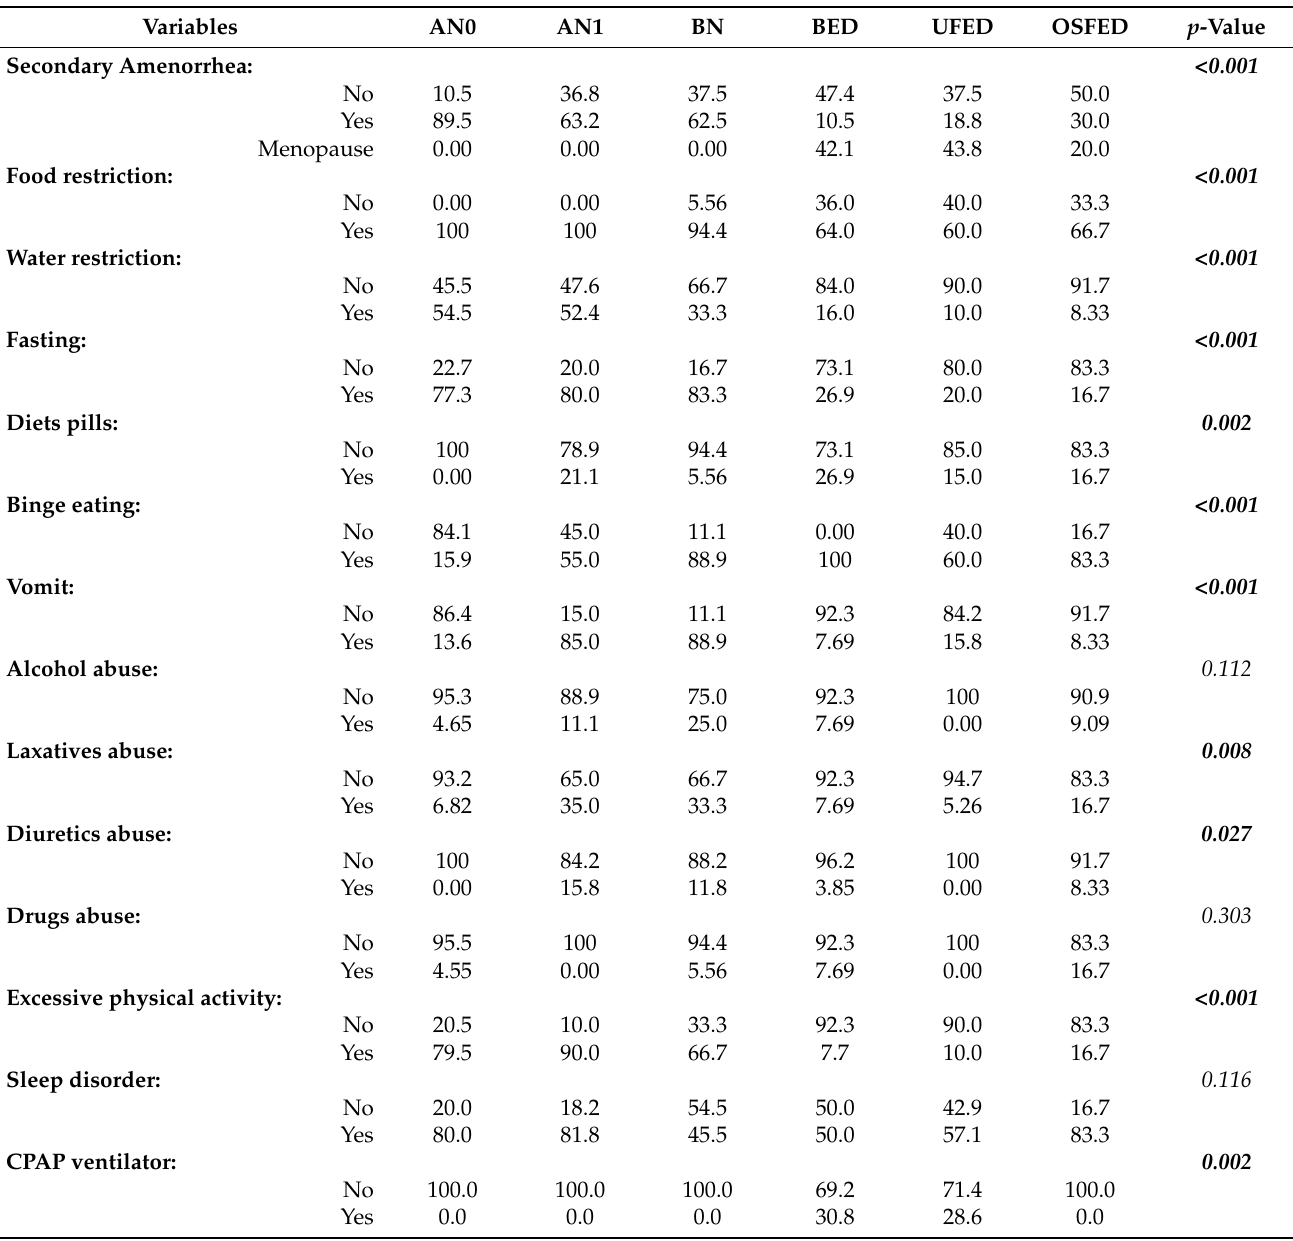
Table 2. Eating behaviors and physical characteristics of ED groups. Descriptive statistics by groups of diagnosis for eating behaviors and physical characteristics expressed as column percentage. The p -values results from the chi-squared test. Statistically significant values are in bold.